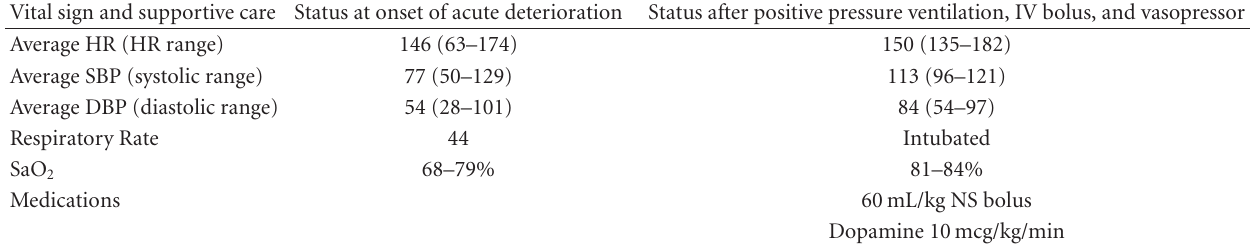
Table 1: Vital signs at the onset of acute deterioration, compared to those values after positive pressure ventilation, saline boluses, and do- pamine.